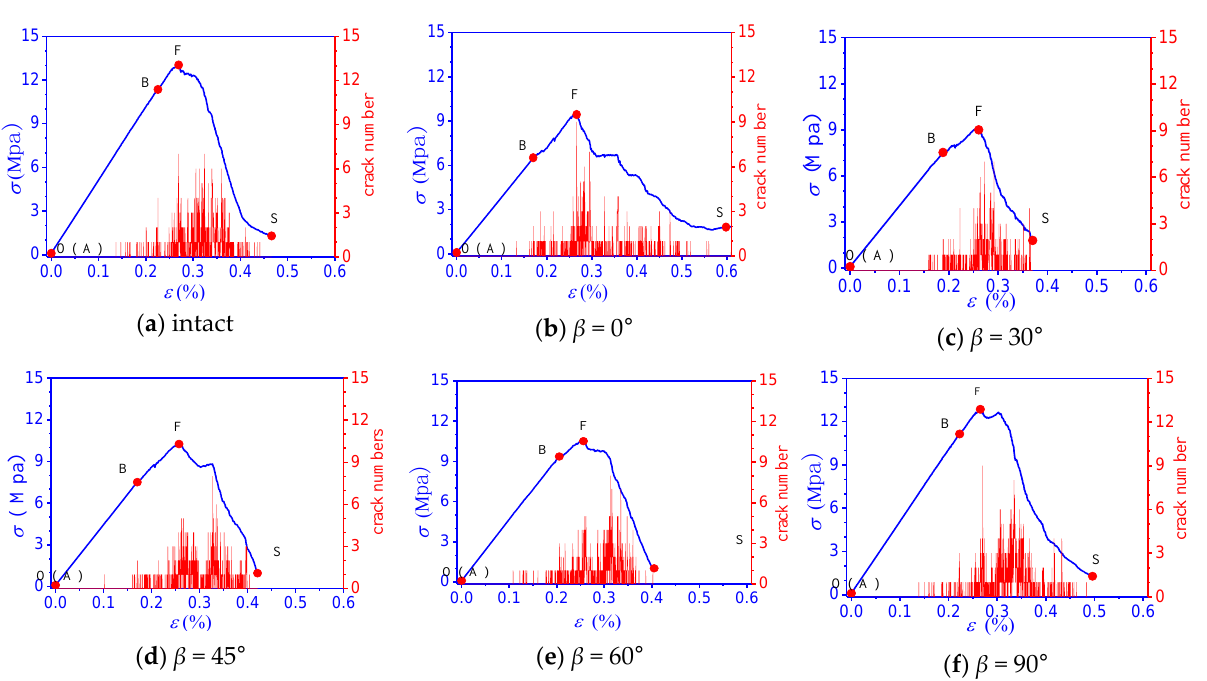
Figure 7. Stress–strain and HPS–strain curves for samples with different crack angles.